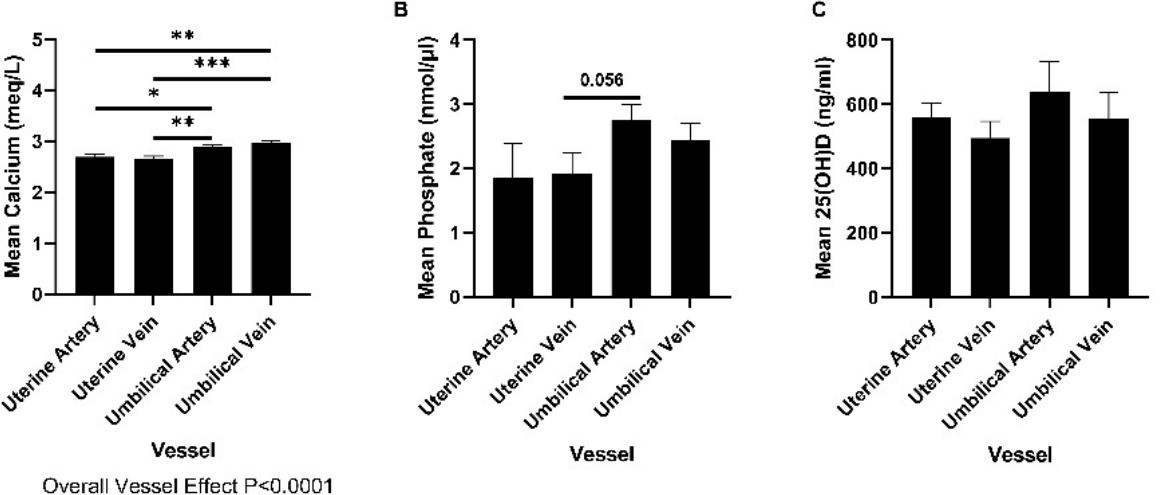
Figure 1. Concentration of calcium ( A ), phosphate ( B ), and 25(OH)D ( C ) in plasma from control RNAi uterine and umbilical blood collected on Day 132 of gestation. Data are presented as means ± SEM. Control RNAi, n = 10. * p < 0.05, ** p < 0.01, *** p < 0.001.